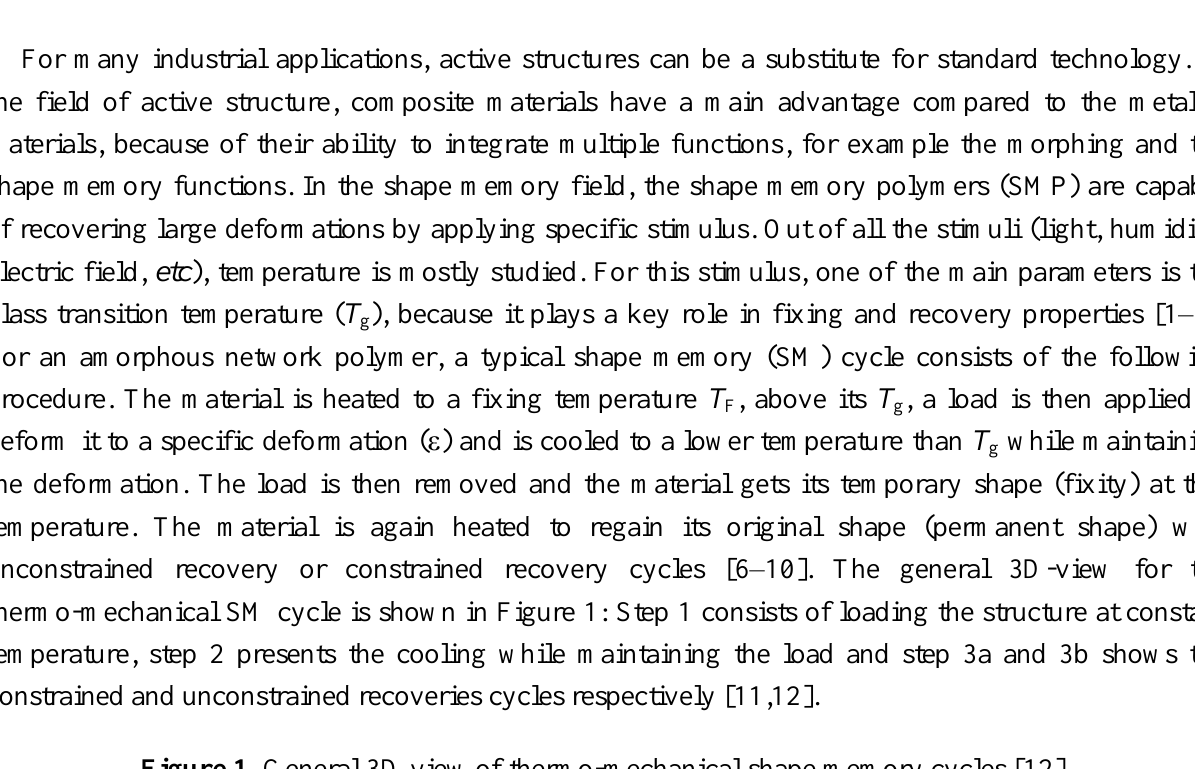
Figure 1. General 3D view of thermo-mechanical shape memory cycles